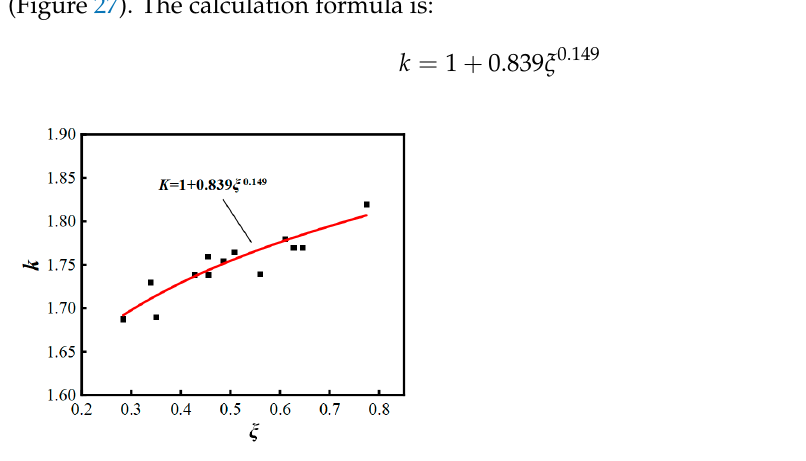
Figure 27. Fitting relationship between k and ξ .